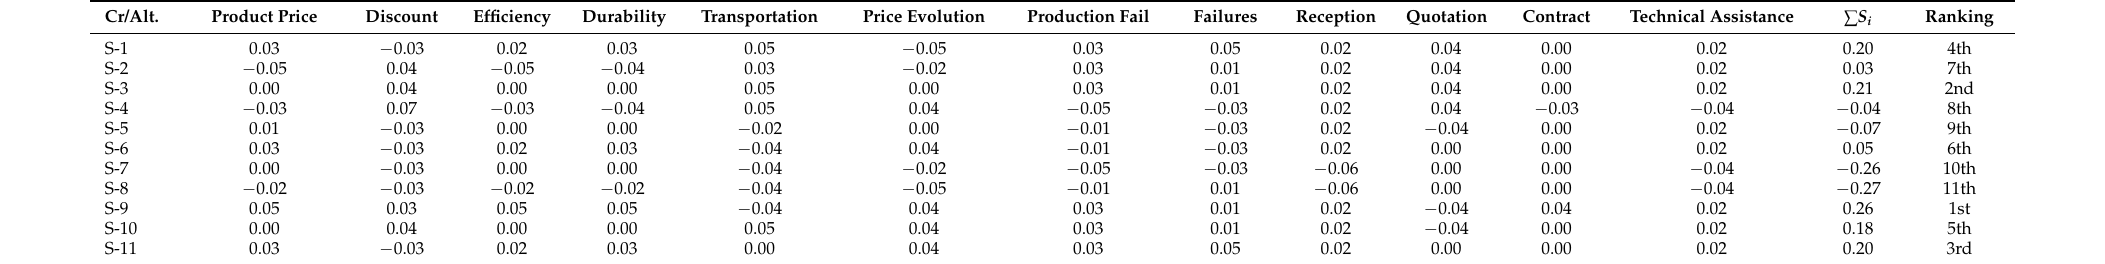
Table 11. Calculation of matrix Q and Final